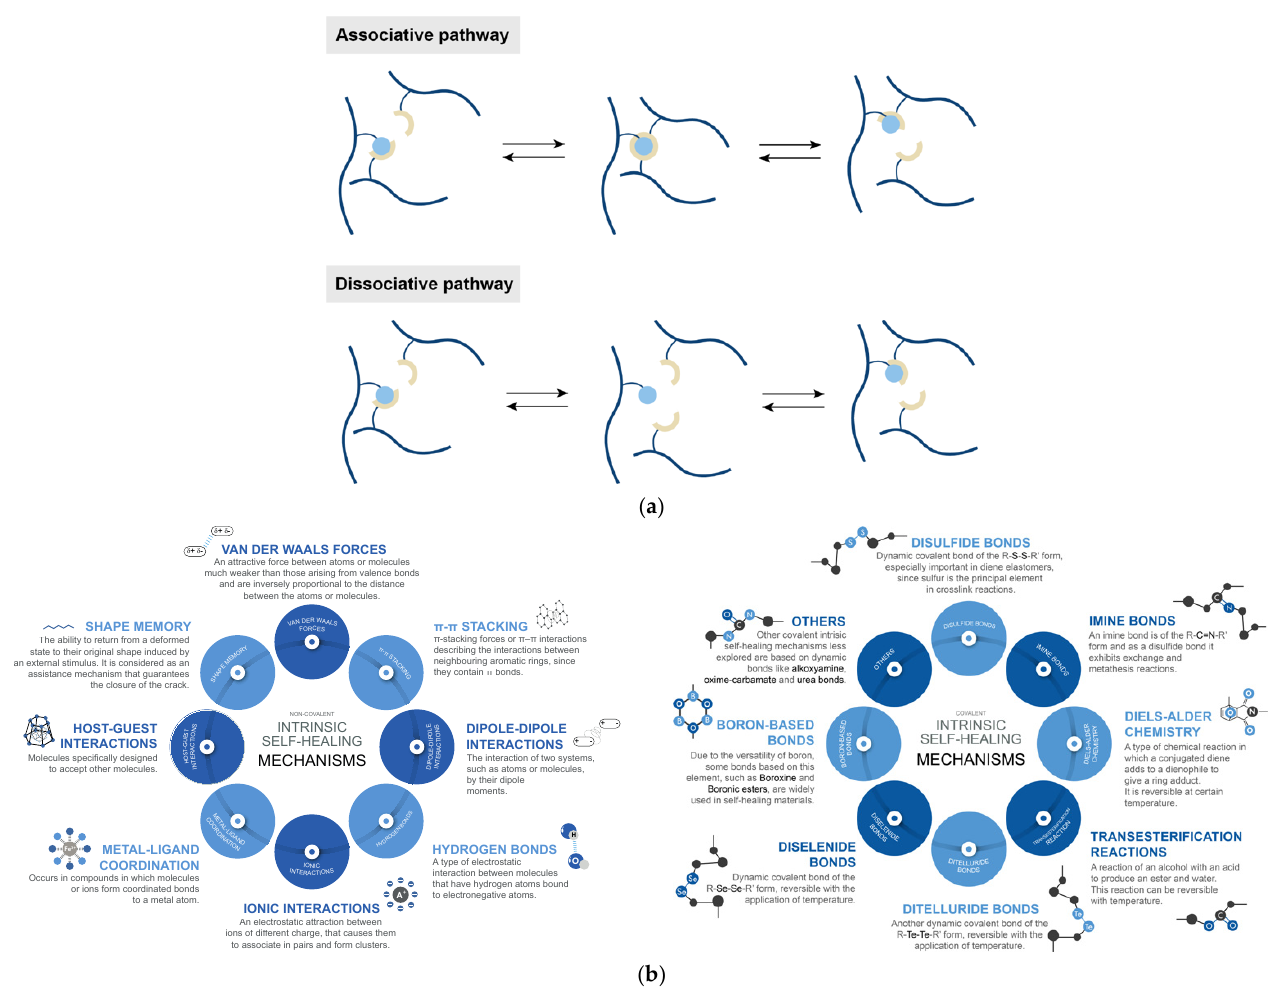
Figure 3. ( a ) Pathways of covalent exchange reactions, ( b ) Intrinsic self-healing mechanisms. Adapted with permission from [49,53]. 2021, Elsevier ( a ) and 2020, Royal Society of Chemistry ( b ).